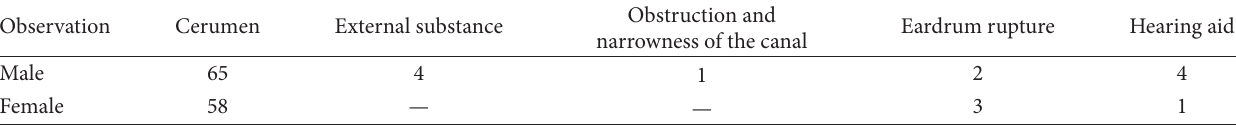
Table 1: Results of direct observation and otoscopic examination based on gender.